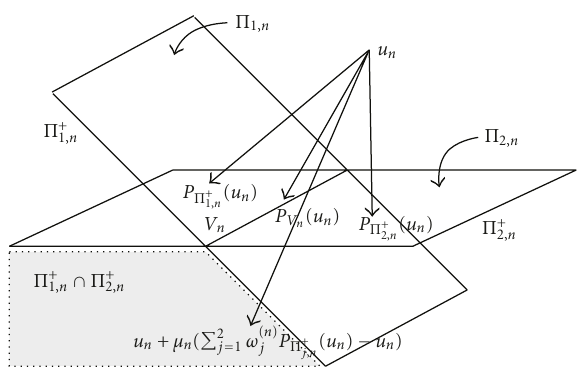
(cid:20) 2 . Π + j , n j = 1